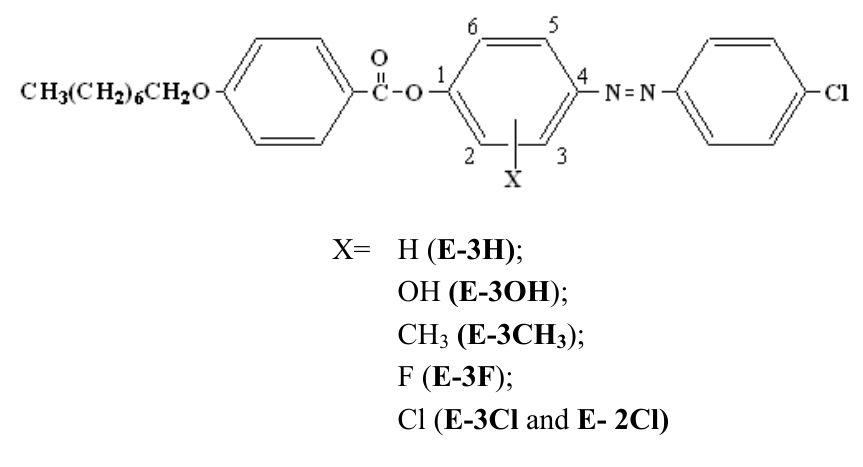
Figure 1. Structures of the studied